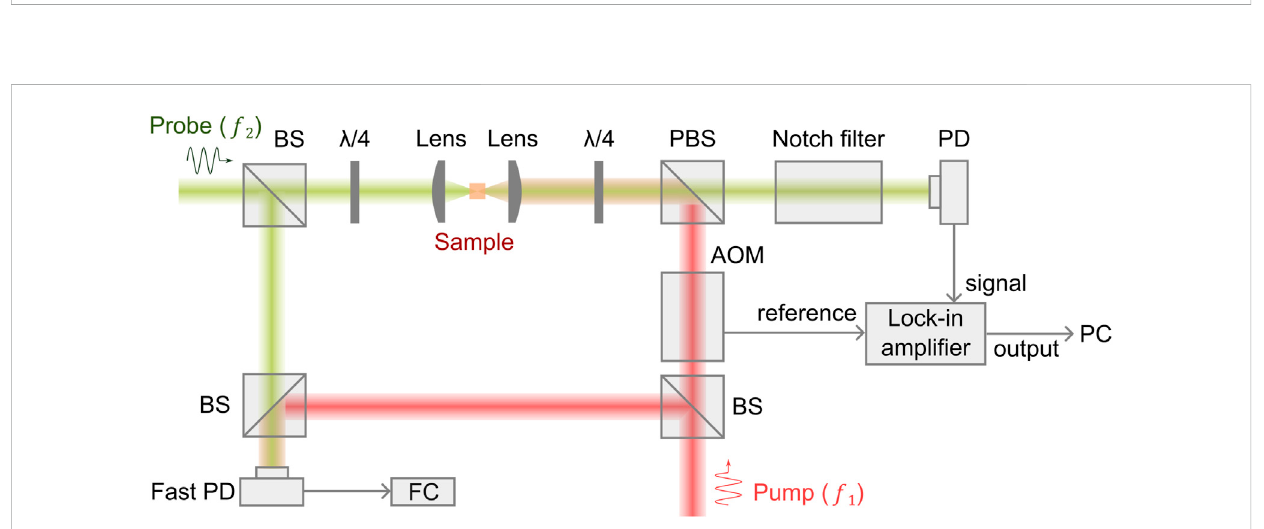
FIGURE 2 Schematic of a representative cw SBM setup. λ /4: quarter-wave plate; PBS: polarized beam splitter; BS: beam splitter; AOM: acousto-optic modulator; PD: photodetector; FC: frequency counter; PC: computer.